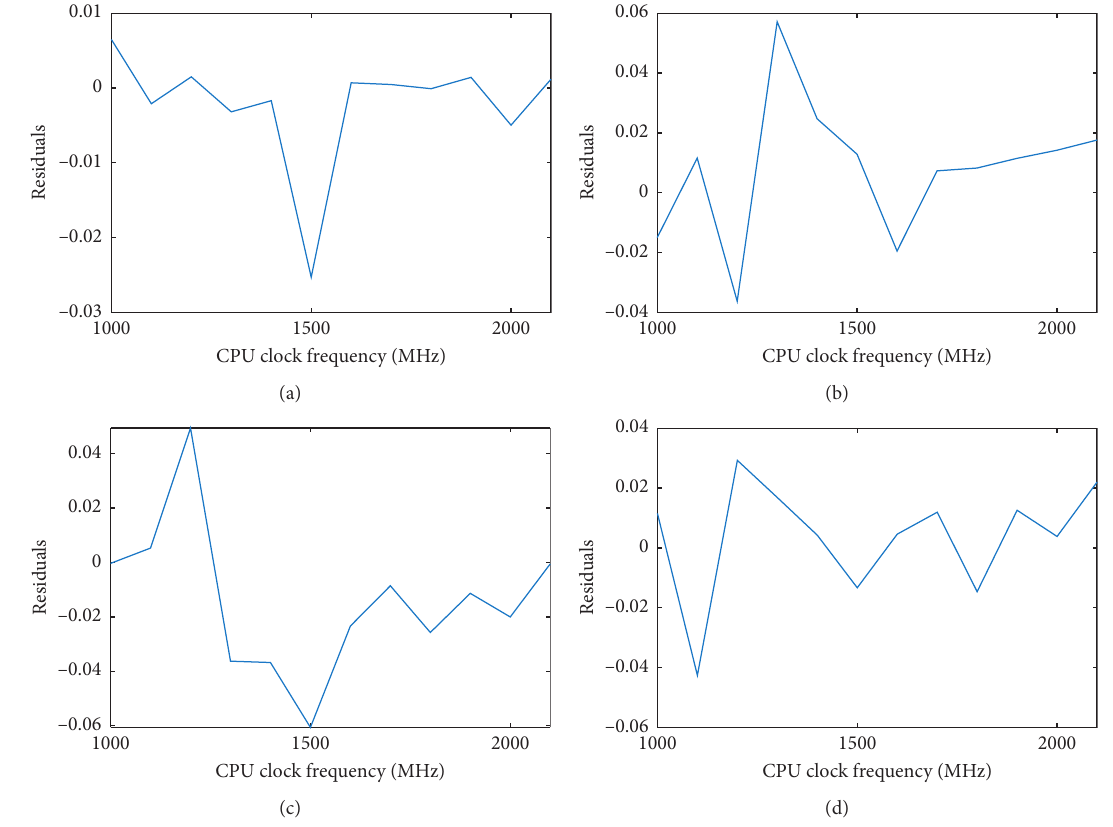
. (a) 5MHz bandwidth. (b) 10MHz bandwidth. (c) 15MHz bandwidth. m